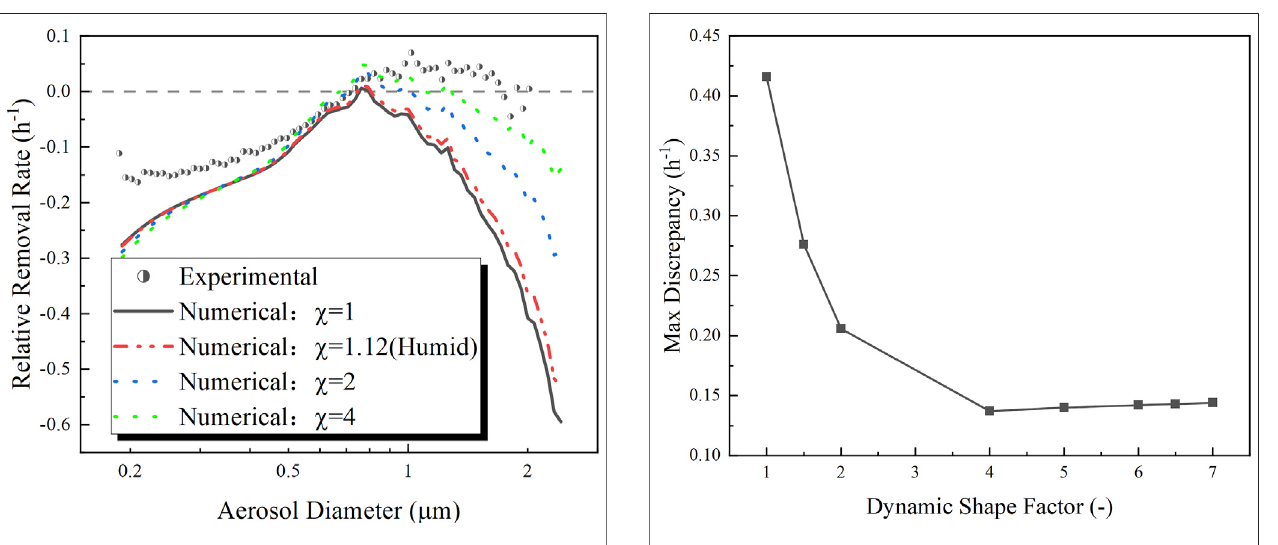
FIGURE 6 | Distributions of the relative removal rate of the experimental result and the numerical